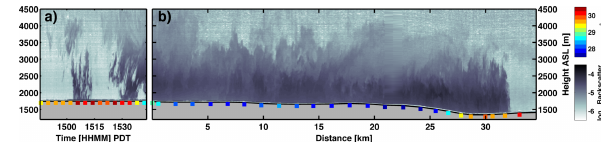
Figure 3. Final intercept and return transect through the smoke layer. (a) Lidar backscatter and truck temperature at intercept F at 15:00PDT, which marks the foremost advance of the smoke-filled density current. (b) Lidar backscatter and truck temperature during the return transect from intercept F to the Hat Creek valley. Panel (a) is plotted against time while the truck was stationary, whereas (b) is plotted against driven distance from intercept